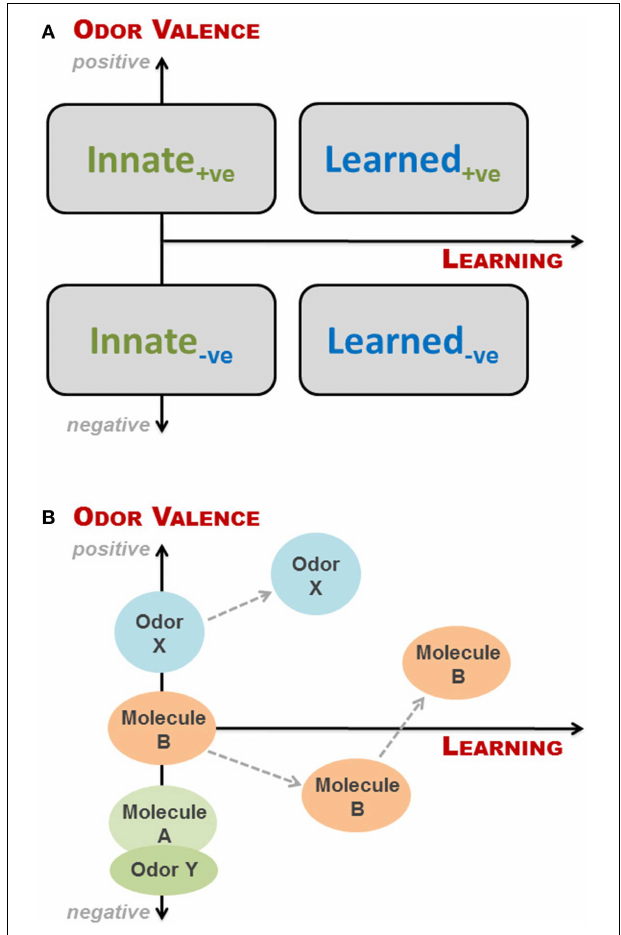
FIGURE 2 | Conceptual framework to describe interspecific olfactory effects for a given animal at a given time. (A) The simplest categorization of odor-based behavioral responses is a binomial split into either innate or learned responses. Likewise, odor valence can be positive ( + ve; attractive odors) or negative ( − ve; aversive odors). These combine into four groupings, as depicted here by rectangles. However, odors can be more or less aversive, and odor-based behavioral responses may change with learning, even when the initial response is innate. We have therefore superimposed the four groupings onto a continual representation of learning and valence, expressing odor valence (y-axis) as a function of learning (x-axis), where positive and negative parts of the y-axis indicate degree of attraction and aversion, respectively. It is important to note that odors, which do not elicit an innate behavioral response, have no valence, i.e., are neutral to the animal and thus placed at the origin; Innate responses require no learning, but may be hard to determine and to differentiate from those arising from odors experienced in utero via amniotic fluid; (B) Examples of how different odors may be categorized relative to each other within the conceptual framework, and how odor valence may change with learning. Odor Y could be the natural smell of a predator, whereas molecule A is TMT or 2-phenylethylamine. Both evoke innate responses, but the natural odor is more fear-inducing. Molecule B is an initially neutral odor, which the animal first learns to find aversive, and subsequently associate with a positive experience. Finally, odor X may be